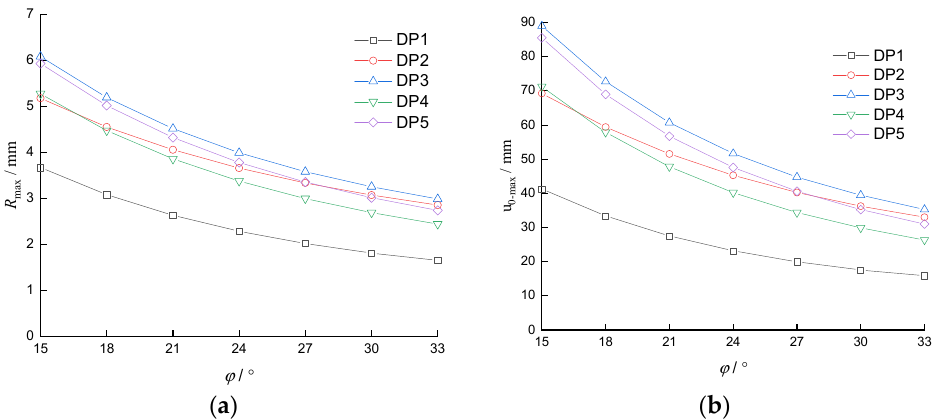
Figure 5. Effect of internal friction angle on radius and maximum displacement of plastic zone: ( a ) plastic zone radius; ( b ) allowable maximum displacement.